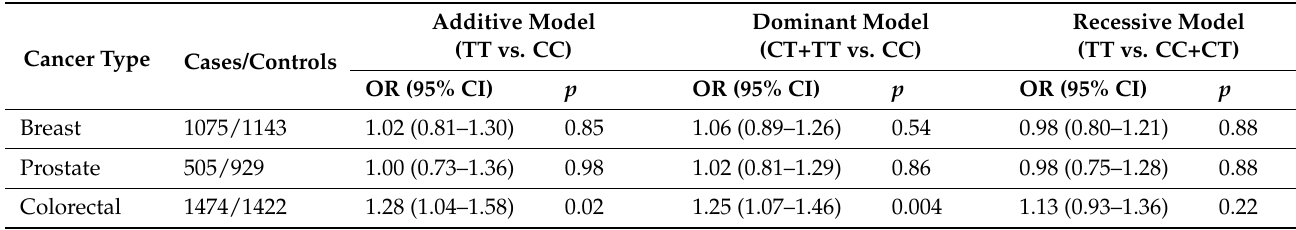
Table 3. Results of meta-analysis for GPX4 (rs713041) SNP and individual